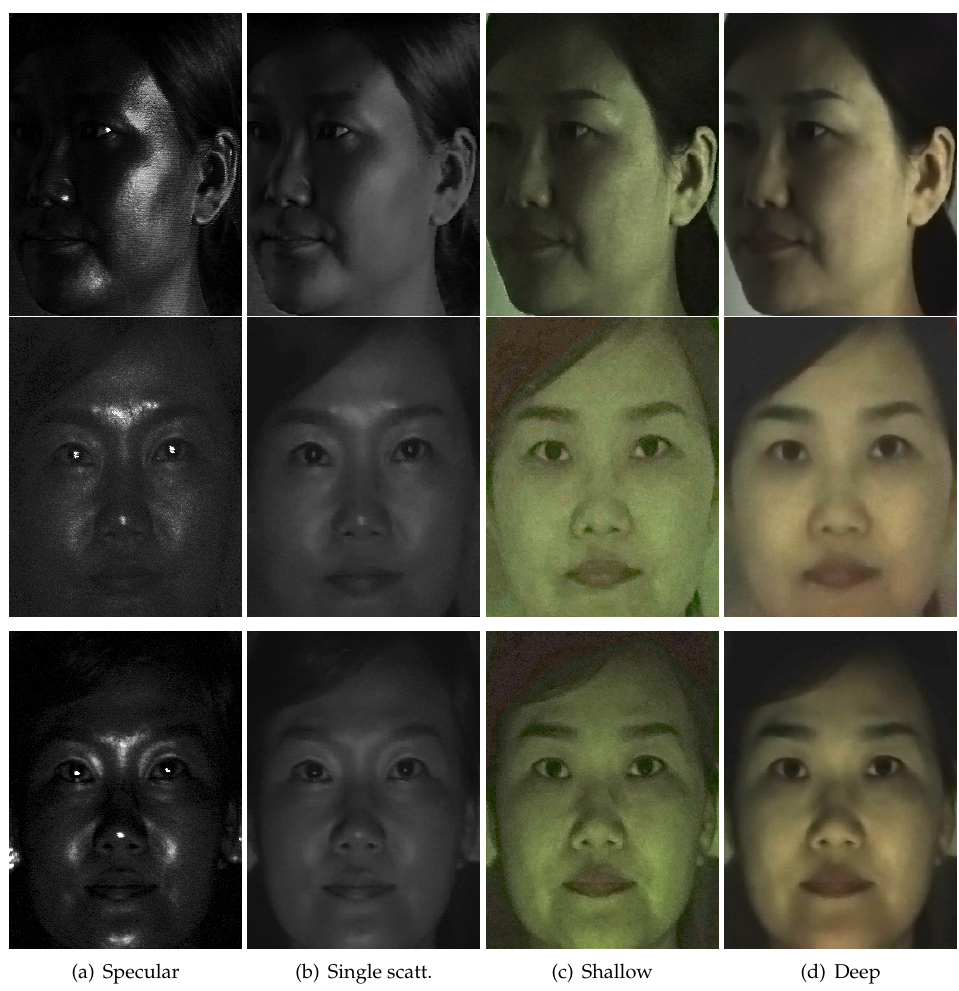
Figure 16. Layered reflectance separation with single-shot TPLF imaging under various illumination conditions. Top row: uniform LCD panel illumination. Centre row: four-point lights. Bottom row: single-point